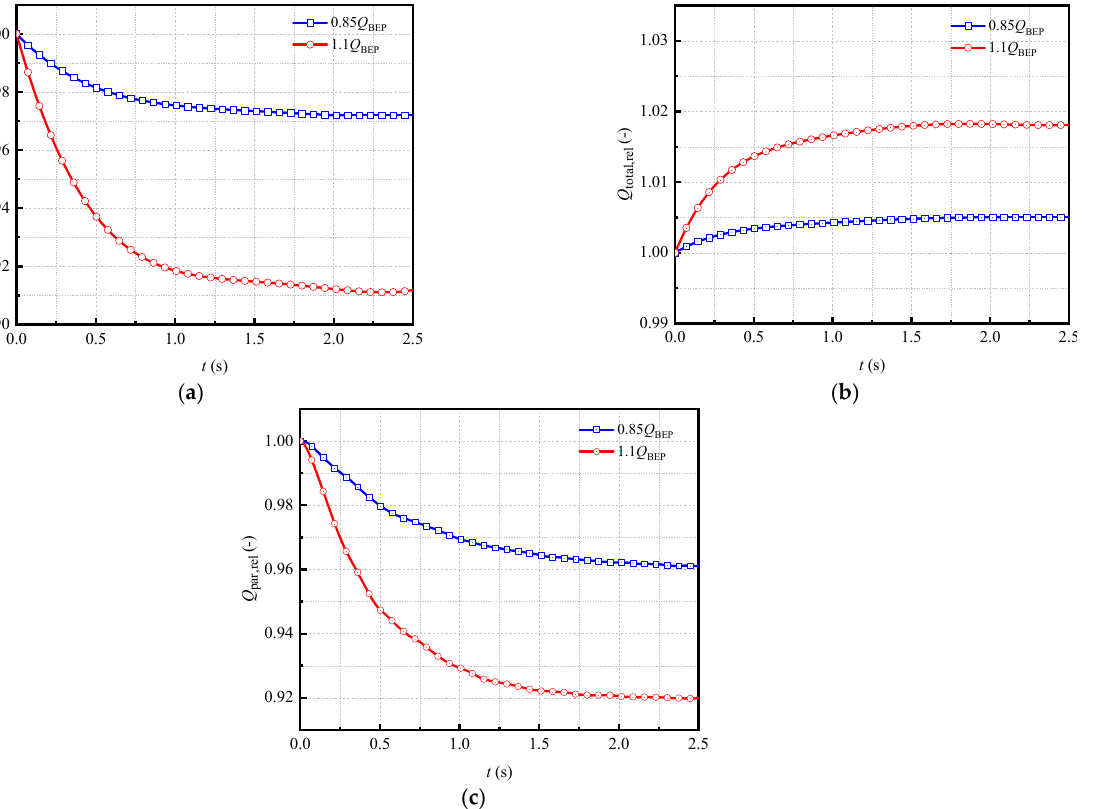
Figure 10. Influence of the turbine runaway on the system return water pressure, system flow rate, and parallel turbine flow rate. ( a ) System return water pressure. ( b ) System flow rate. ( c ) Parallel turbine flow rate.